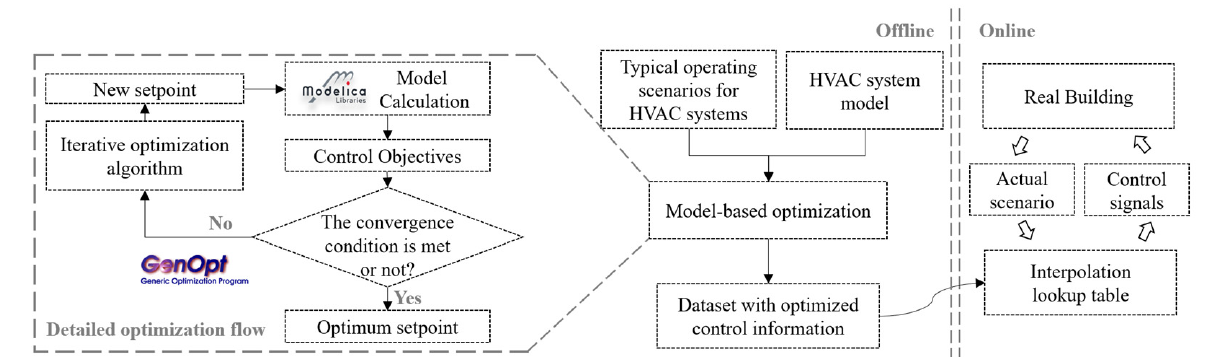
Figure 5. The diagram of the offline optimization framework.